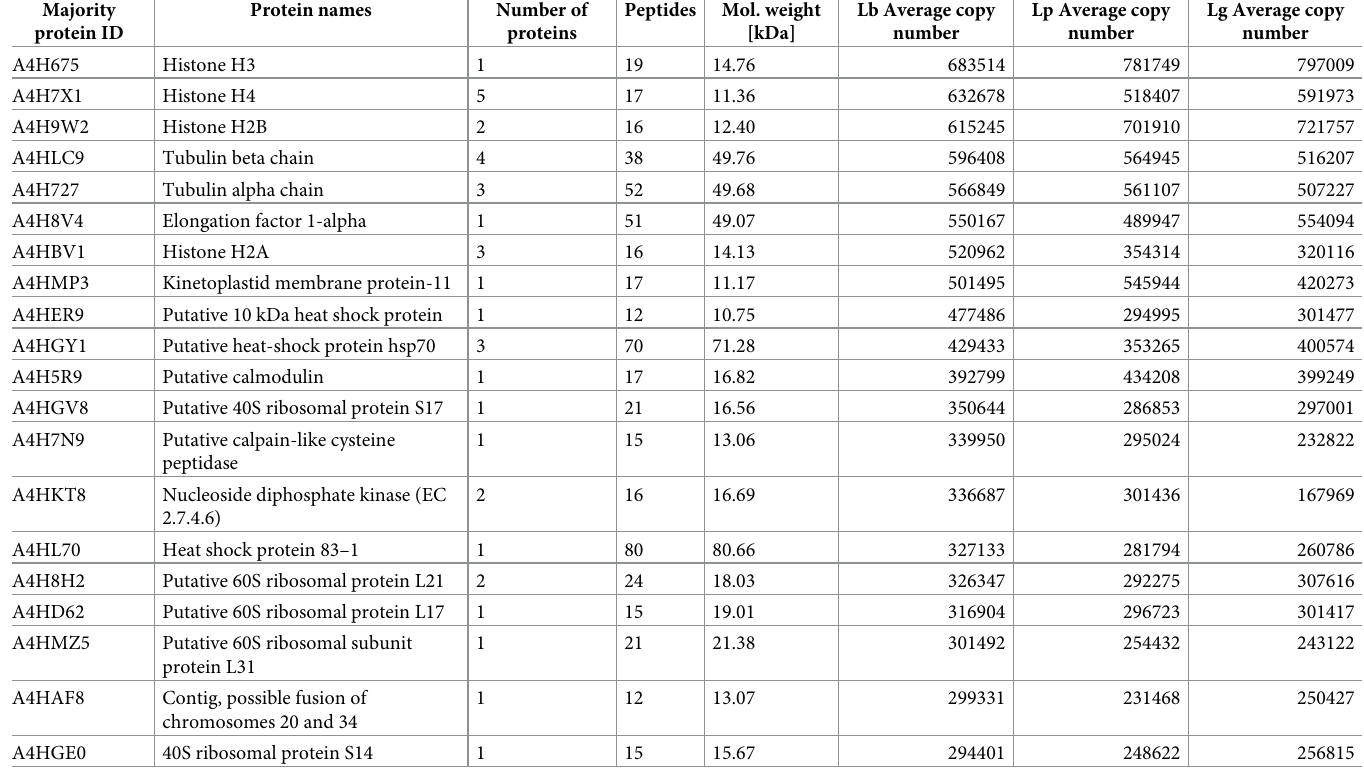
Table 2. Top 20 most abundant protein groups in Leishmania ( Viannia ) proteomes in terms of protein copy number. Protein IDs according to UniProt. Detailed information in S2 Table. Lb: L . braziliensis ; Lp: L . panamensis ; Lg: L . guyanensis